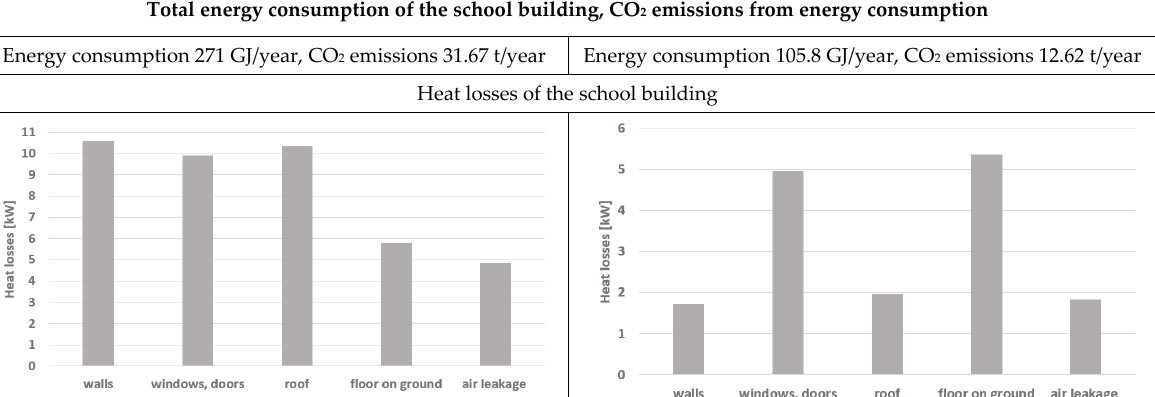
Figure 3. Photographs of the east wing of the school building campus with the classroom in its former and renovated states.